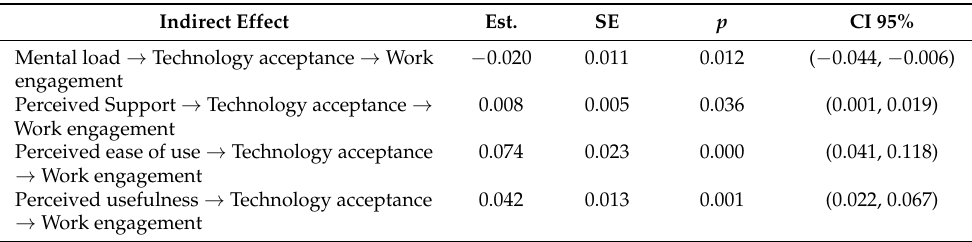
Table 4. Indirect effects using bootstrapping (2000